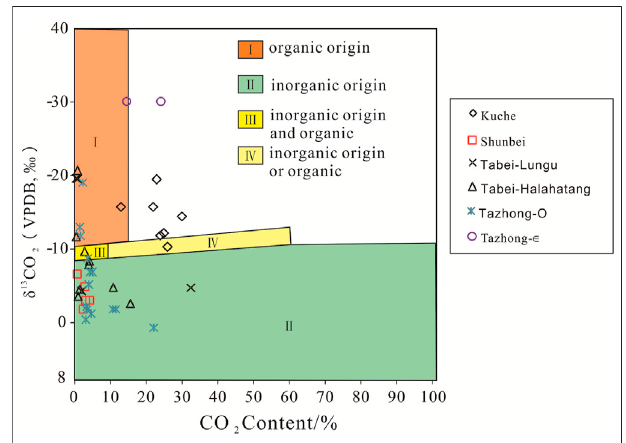
FIGURE 10 | CO 2 - δ 13 C CO2 of deep natural gas in Tarim. (base map according to Dai et al.,